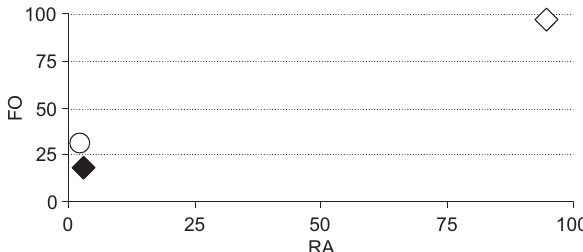
Figure 2. Graphic representation of the results obtained with the analysis of occurrence (FO) and abundance (RA) for invertebrates (  ), vertebrates (  ) and plants (  ).